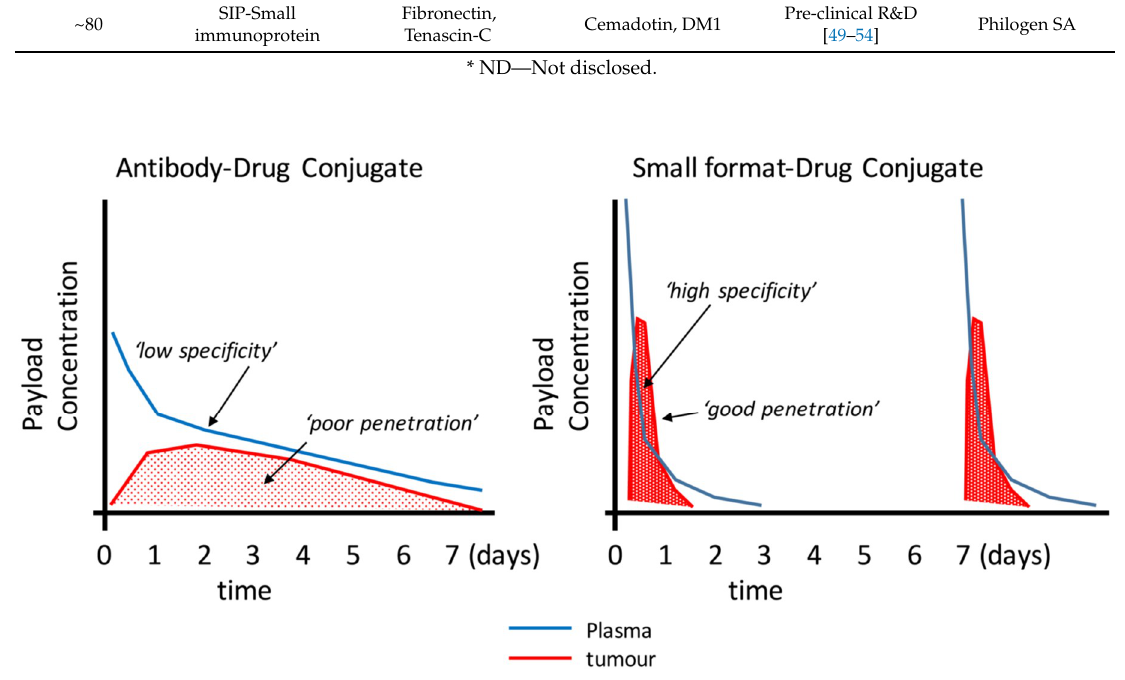
Figure 2. Schematic illustration of the potential mechanistic and pharmacokinetic differences between an ADC (e.g., from [110] and small format-drug conjugate. Many reports have demonstrated the uptake and clearance properties of large and small targeting agents. This figure proposes how smaller formats my bring certain advantages such as faster plasma clearance and improved penetration. Smaller formats may require more frequent doses as shown here.